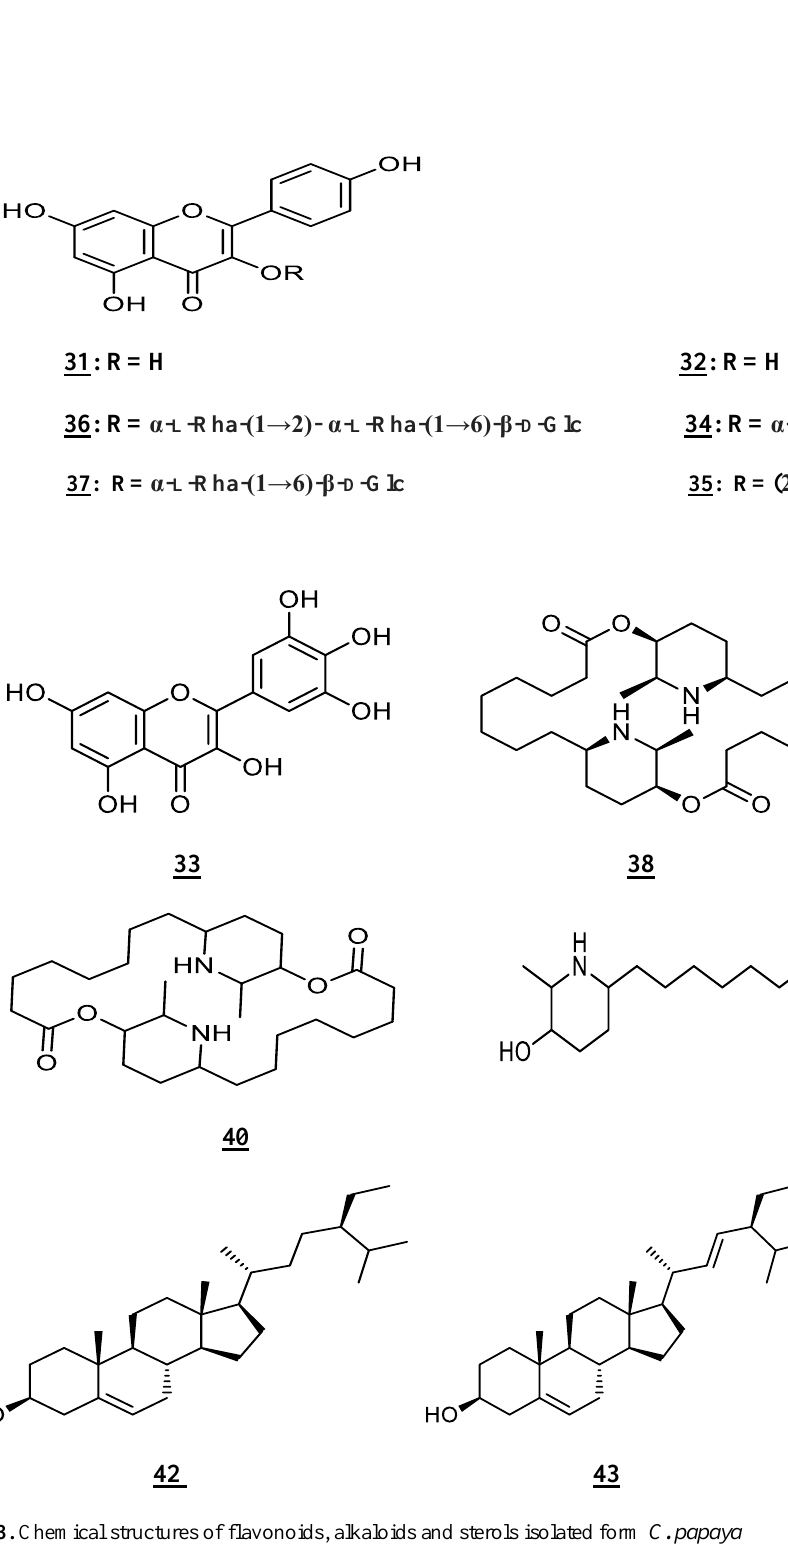
Fig. 3. Chemical structures of flavonoids, alkaloids and sterols isolated form C.